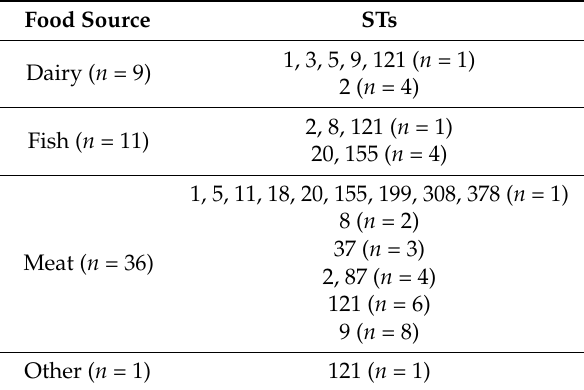
Table 2. L. monocytogenes ST distribution among different food